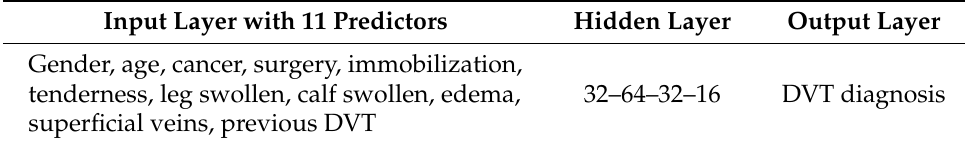
Table 4. Proposed sequential model (NN) for DVT